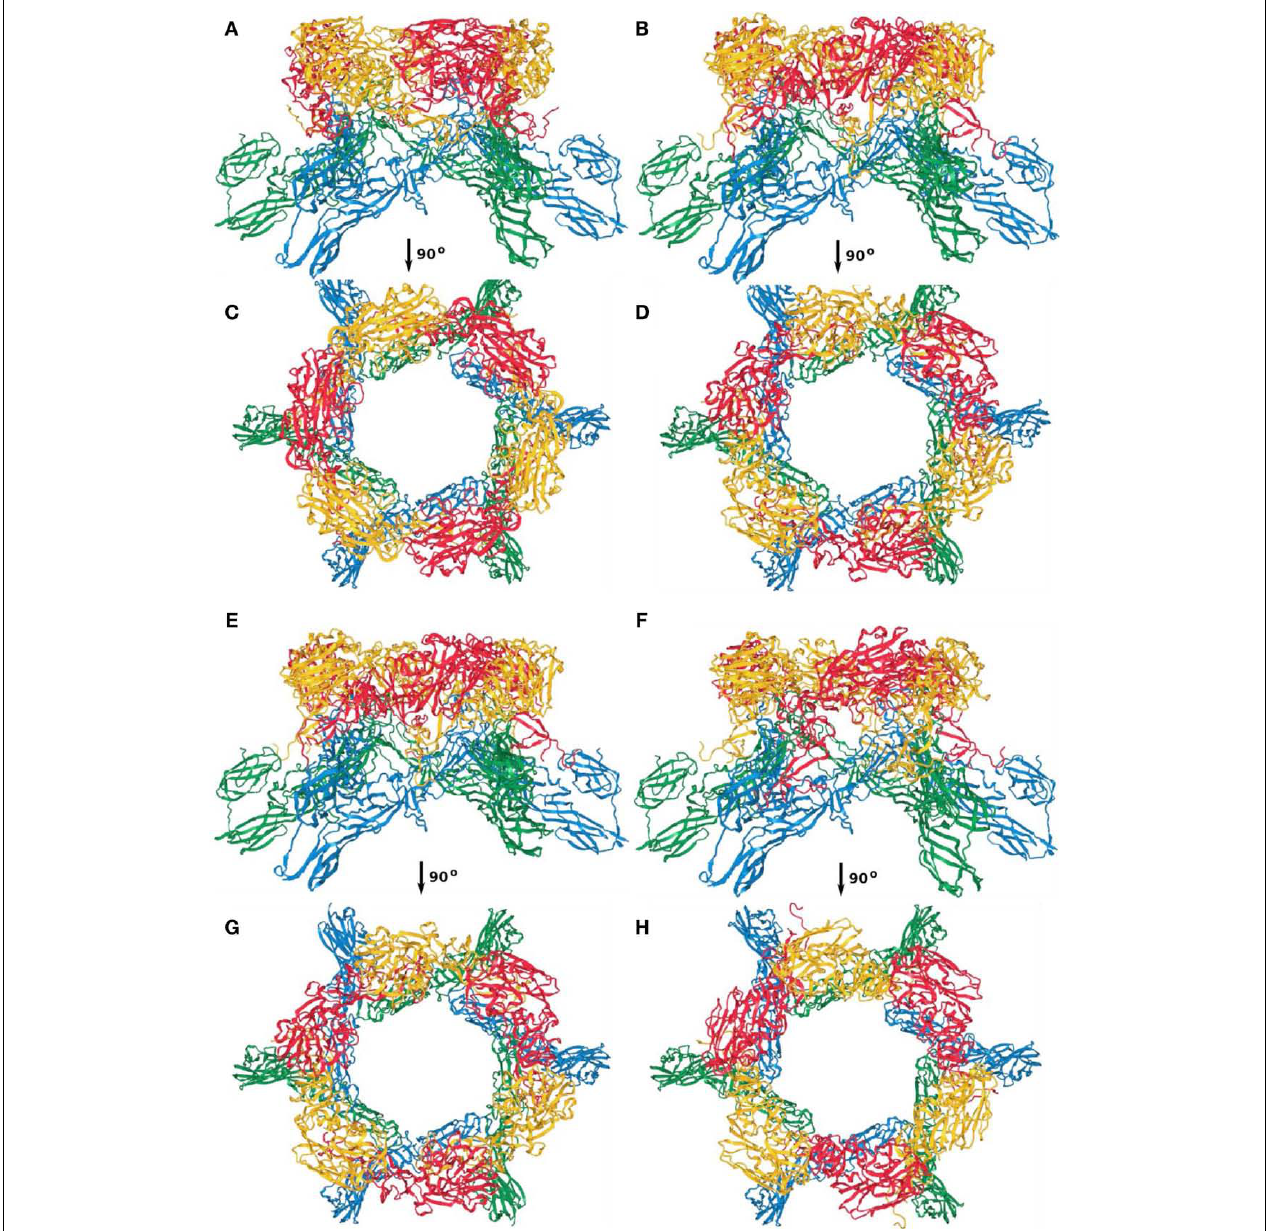
FIGUREA1 | Capsomer twofold axis; (A,C) first; (B,D) second; (E,G) third; (F,H) fourth top-scoring